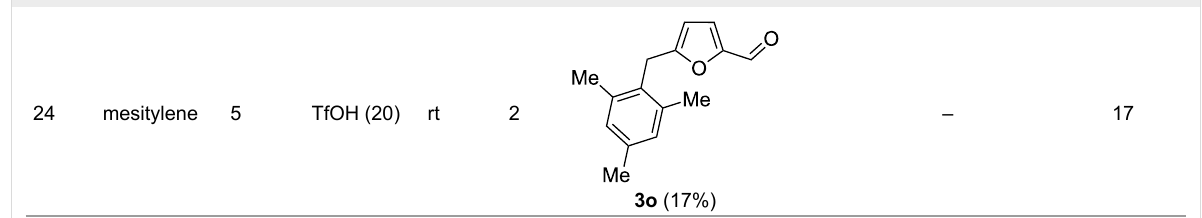
Table 4: Reactions of 5-HMF ( 1a ) with arenes under the action of TfOH or acidic zeolite CBV-720.